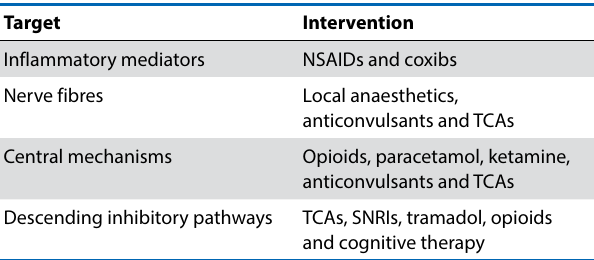
Table 1: Pain pathway targets and